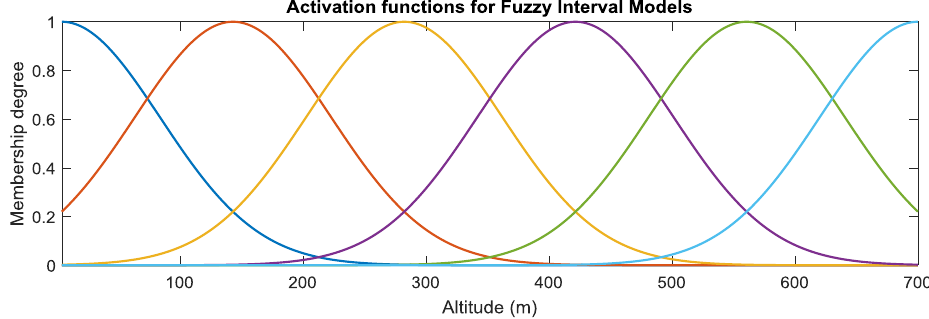
Figure 3. Gaussian membership functions associated to the FIM depending on the flight height h.